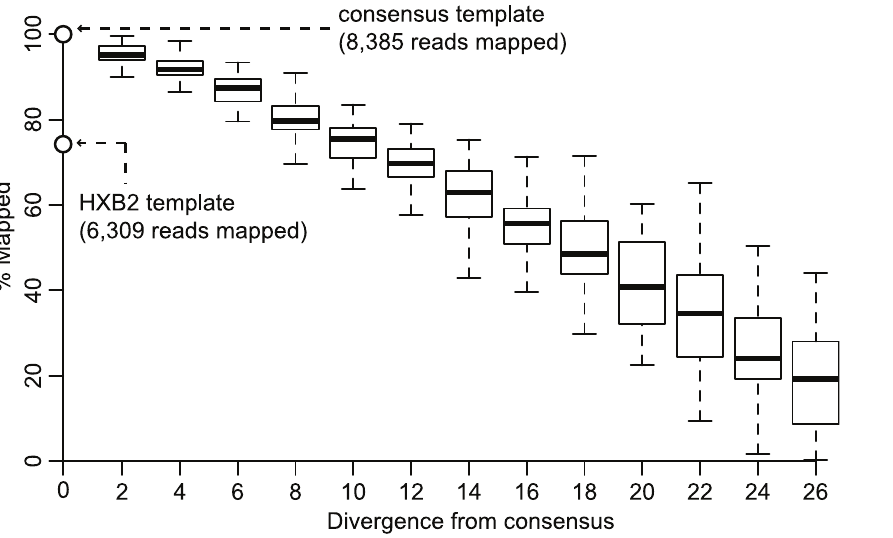
Figure 2. Relationship between k-mer mapping and diversity. As divergence from the consensus template increases the number of reads successfully mapped decreases. Each box and whisker (1.5 times the inter-quartile range) represents 50 repetitions of the mapping process at the level of divergence indicated on the x-axis. The bottom circle, on the y-axis, indicates the percentage of reads mapped to HXB2 in relation to the total number mapped to the consensus template (top circle). The dataset used for this comparison was patient D at